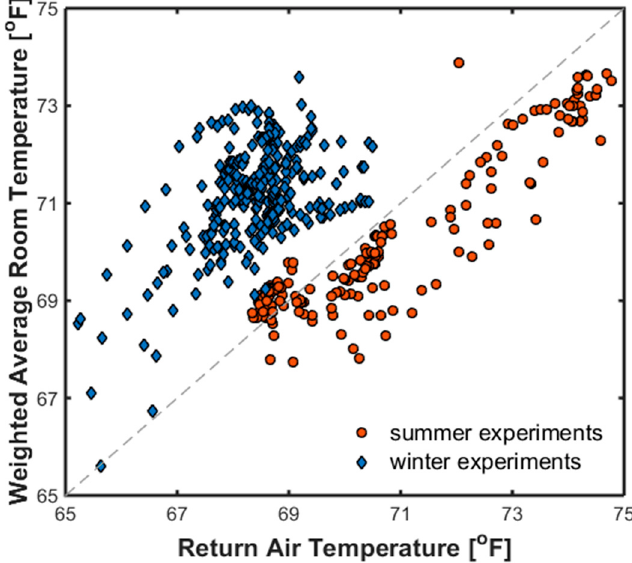
Figure 4. Temperature difference between room average and RTU return air temperatures.